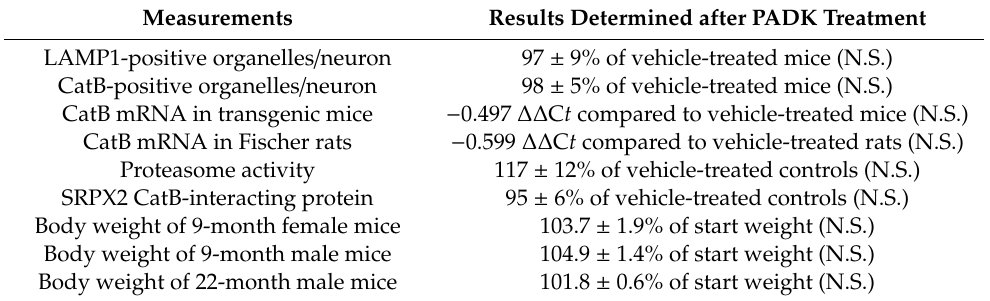
Table 2. Assessments related to selectivity, safety, and gender for CatB-enhancing compound PADK. LAMP1—lysosome-associated membrane protein 1; mRNA—messenger RNA; SRPX2—sushi repeat-containing protein X-linked 2. Measurements Results Determined after PADK Treatment LAMP1-positive organelles /